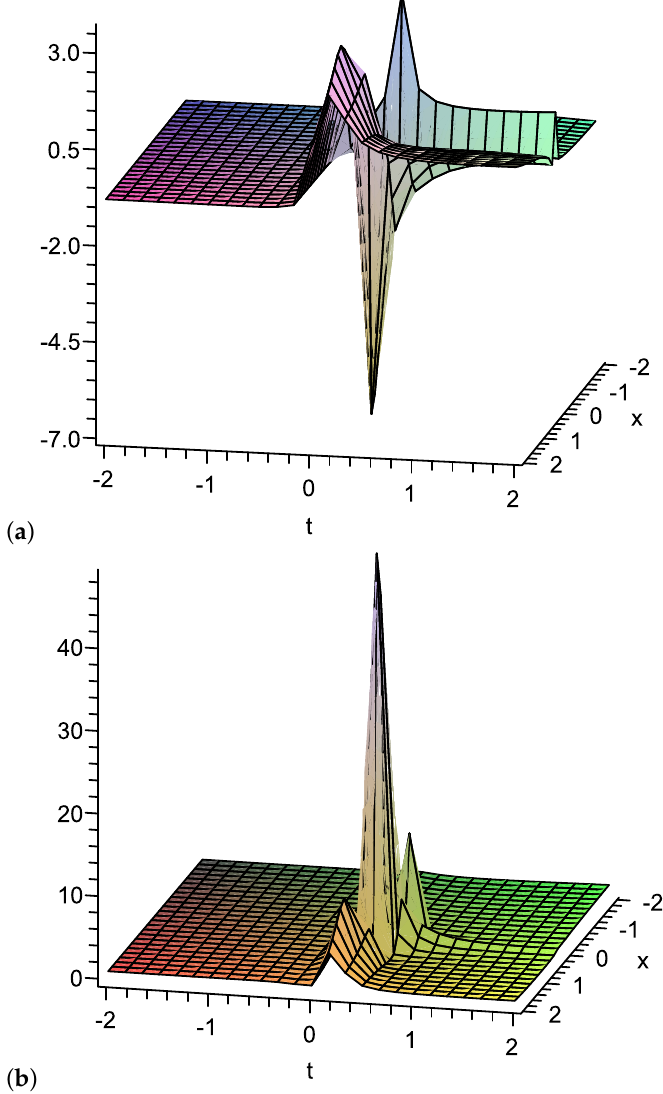
Figure 8. The first and second moments for the random solution ˜ sq variable and − 2 ≤ t , x ≤